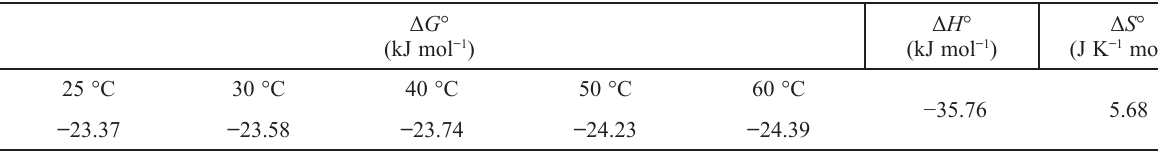
Table 3 – Adsorption isotherm parameters for SR 3BL dye adsorption onto Oxalis